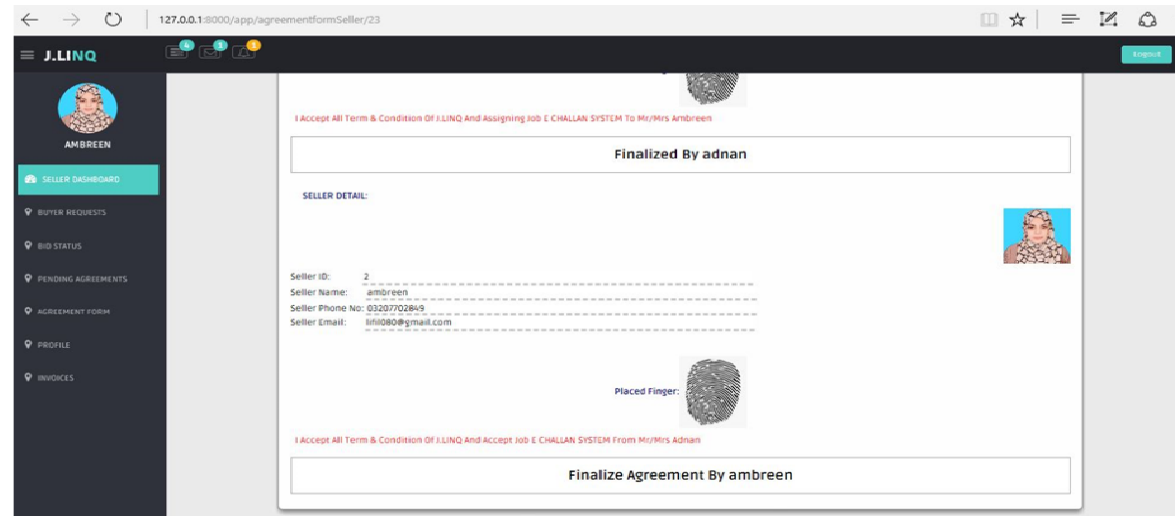
Figure 18. Finalization of the agreement with the biometric signature from the seller’s side.